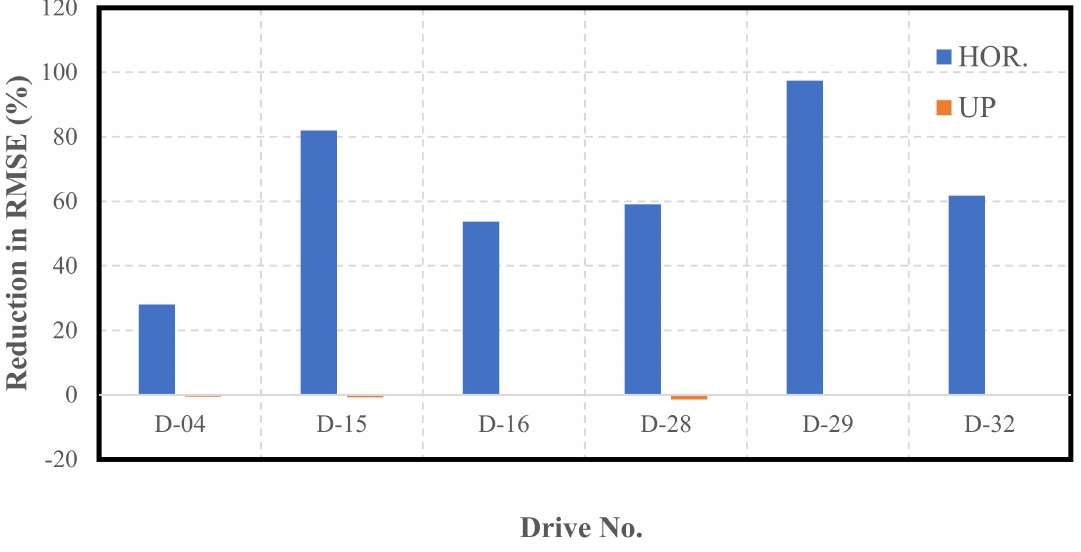
Figure 20. Reductions in RMSE of KITTI highway